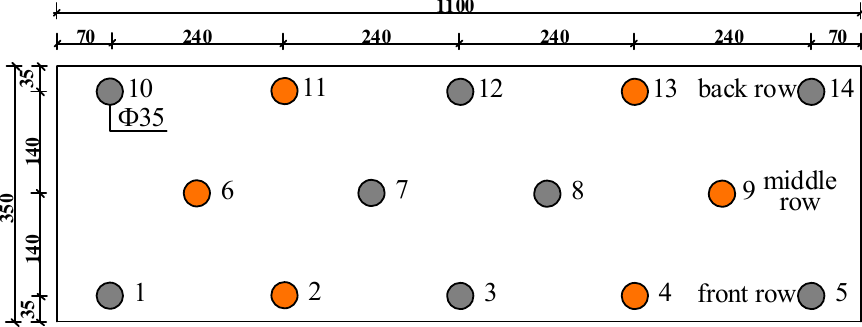
Figure 8. The layout of the test components (unit: mm).